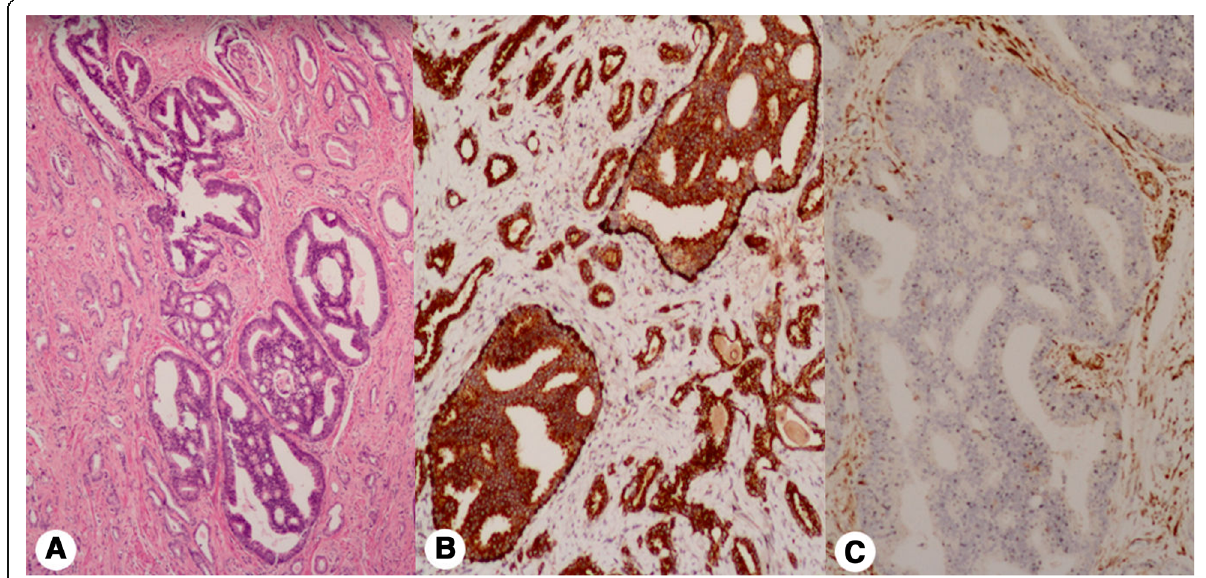
Fig. 2 Intraductal carcinoma of the prostate in a prostatectomy specimen associated with invasive adenocarcinoma. a HE stain (40×) shows expanded ducts with loose and dense cribriform morphologies surrounded by small infiltrative glands of acinar adenocarcinoma. b Immunohistochemistry of a cocktail using basal cell markers (p63 and high molecular weight cytokeratin, 34BE12) and Alpha-methylacyl- CoA racemase (AMACR) (40×): intraductal carcinoma show preserved basal cell layer while luminal cells of intraductal carcinoma and invasive adenocarcinoma express AMACR. c PTEN immunohistochemistry (100×) shows loss of nuclear and cytoplasmatic express of PTEN protein in intraductal carcinoma while preserved stain is seen in adjacent